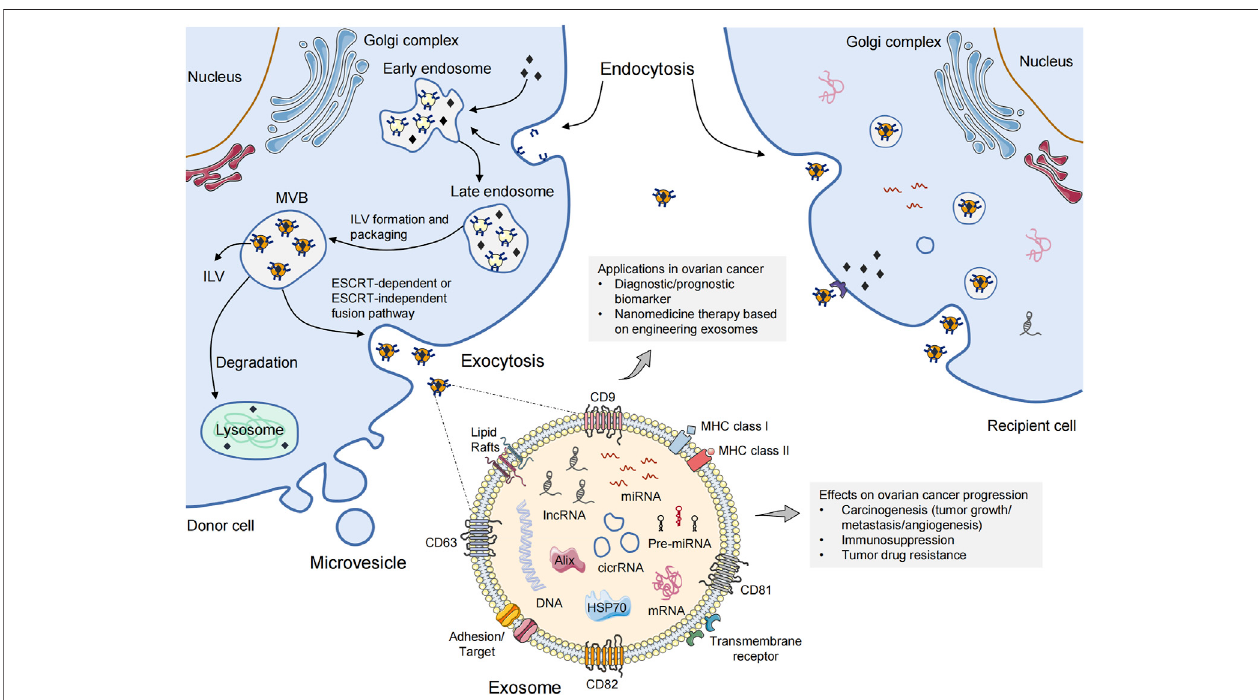
FIGURE 1 | The biogenesis and cellular-uptake of extracellular vesicles. Microvesicles are released directly from the plasma membrane via outward budding. The biogenesis of exosomes follows the endocytic-exocytic pathway, inward budding from the plasma membrane to form early endosomes. Late endosomal membrane invagination results in the loading of cytosolic proteins/RNAs, which further forms the exosomal precursor – intraluminal vesicles (ILVs) in multivesicular bodies (MVBs). Exosomes are then secreted into the extracellular space after fusion with the plasma membrane via an ESCRT-dependent or ESCRT-independent pathway. Exosomescanbetakenupbyrecipientcellsthroughendocytosis, directfusion,orbindingtosurfaceproteins,causingthetransferofoncogeniccargoes,andchanging the biological behaviors of recipient cells. A multitude of non-coding RNA species (e.g., miRNAs, circRNAs, lncRNAs) are contained in exosome. The roles of exosomes in ovarian cancer are also shown. ESCRT, endosomal sorting complex required for transport; MHC, major histocompatibility complex; miRNA, microRNA; circRNA, circular RNA; lncRNA, long non-coding